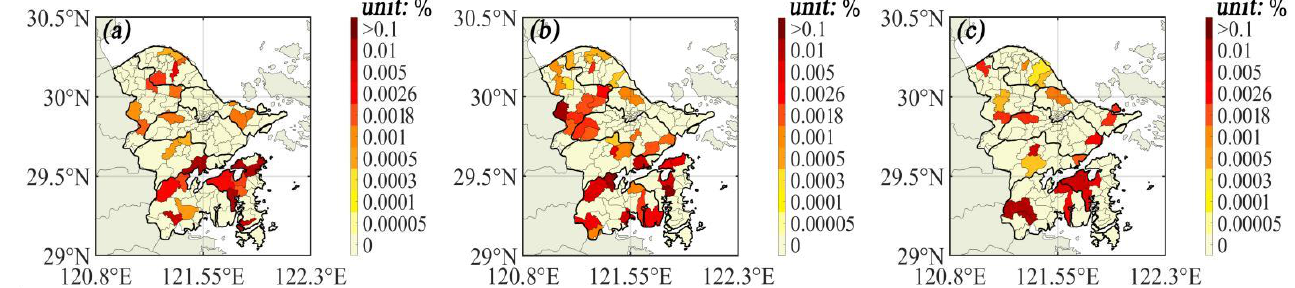
Figure 6. Insured loss rate of townships due to type I typhoons. ( a ) 1416 Fung-wong; ( b ) 1509 Chan- hom; ( c ) 1909 Lekima.